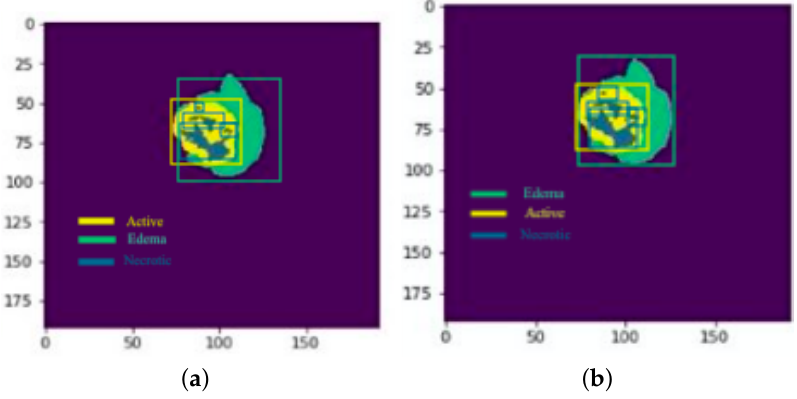
Figure 29. Results: Slice 2: ( a ) Actual result ( b ) Predicted